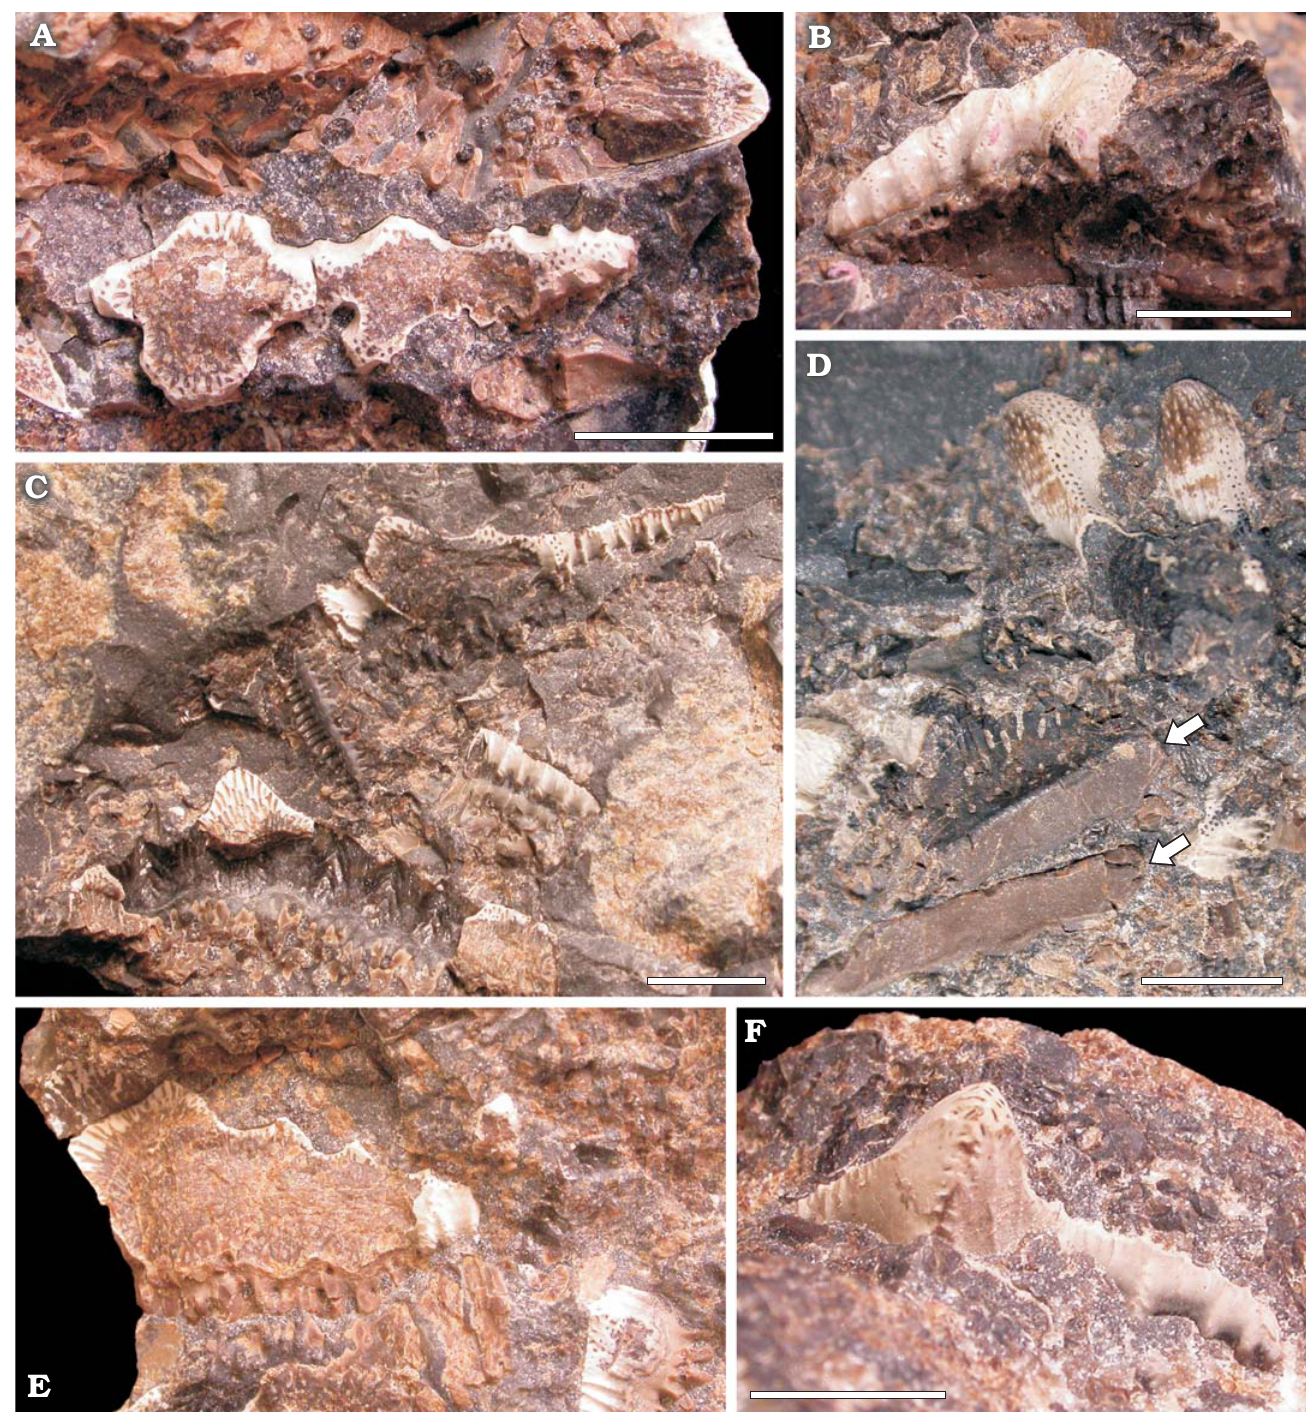
Fig. 6. Teeth of the eugeneodontiform shark Campodus agassizianus De Koninck, 1844, in the fragments of nodule from the Kinderscoutian of Derbyshire, UK. A . A half of horizontal section of a large tooth (GSM 105471a). B . Lingual view of a half of a medium-sized tooth with well preserved surface (GSM 105471b). C . Close-up of long teeth (GSM 105524). D . Two cusps (mamelons) of a large tooth with abraded surface and uncovered tubular dentine ca- nals; at the bottom part (arrows): aboral views of bases of two teeth (GSM 105471c). E . A half of a section of a large tooth (specimen not located in the collection during the second investigation). F . The upper part of a crown with a relatively high median cusp (GSM 105471d). Scale bars 5 mm apart from E where it is